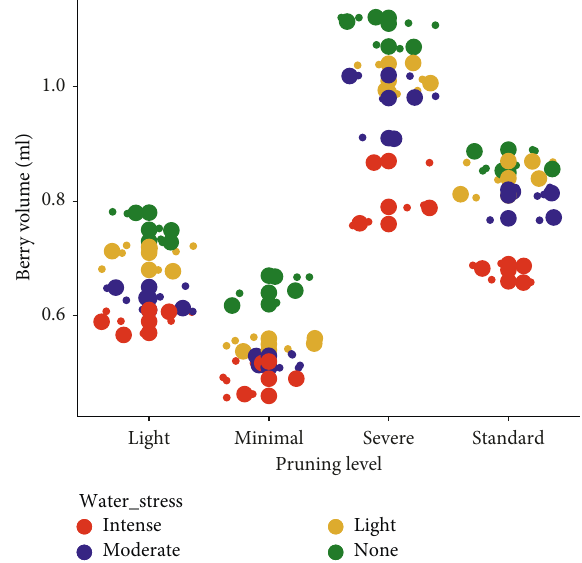
Figure 1: Response of grapevine berry volume to post-veraison water stress and pruning